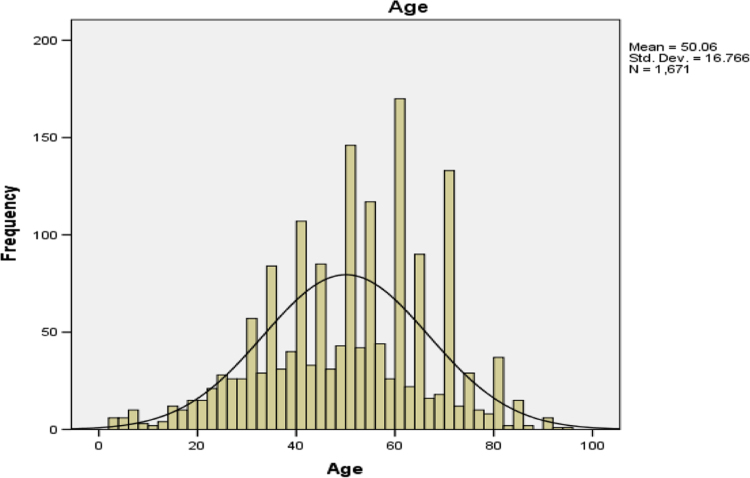
Age of the patients.